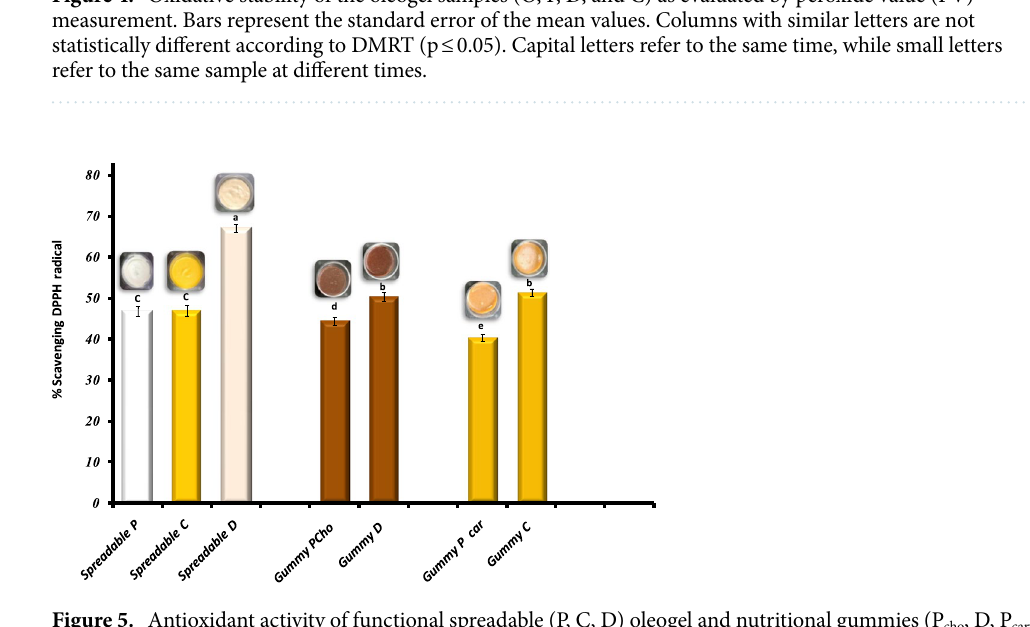
Figure 5. Antioxidant activity of functional spreadable (P, C, D) oleogel and nutritional gummies (P cho , D, P car , C,). Columns with similar letters are not statistically different according to DMRT (p ≤